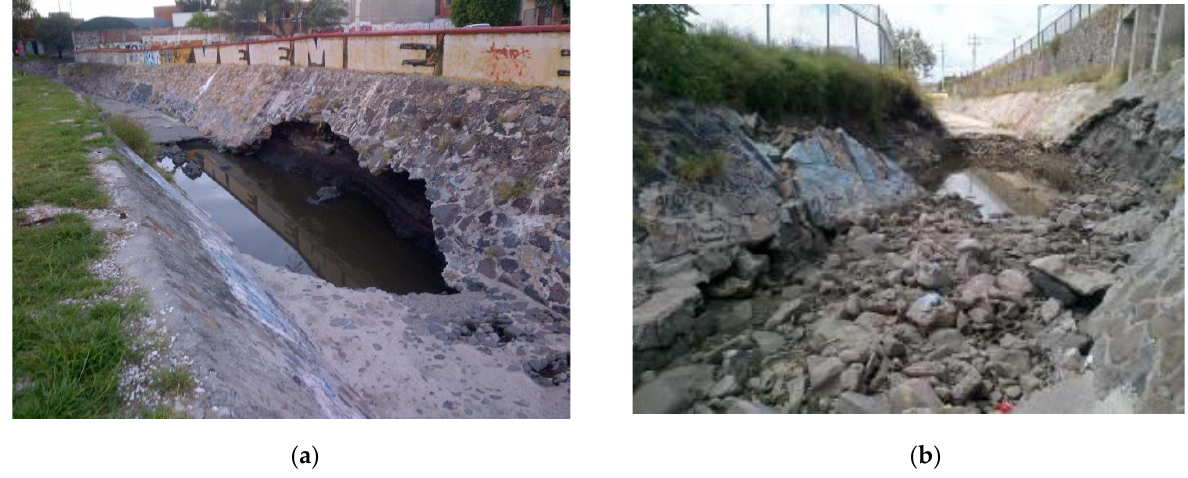
Figure 6. Evidence of destruction of urban channel bed and banks. ( a ) Destruction of banks and loss of rock-fill; ( b ) wrecked urban storm drainage channel.